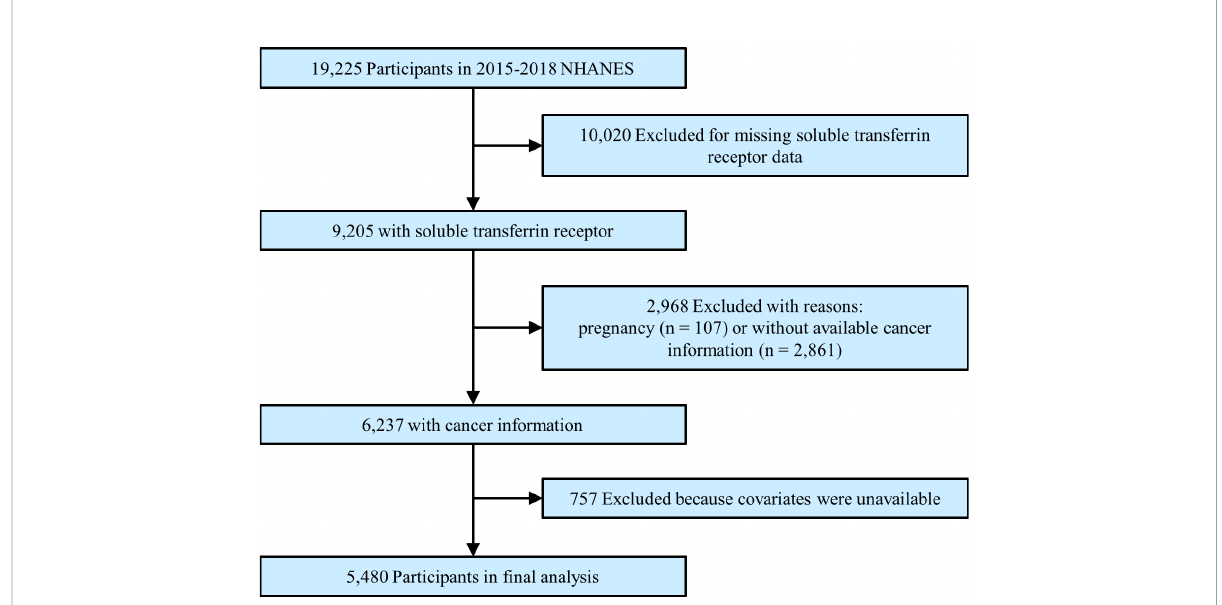
FIGURE 1 Study fl owchart. Flow chart showing the process of participants selection. Of 19,225 participants from 2015 to 2018 of National Health and Nutrition Examination Survey (NHANES), 5,480 remained in the fi nal